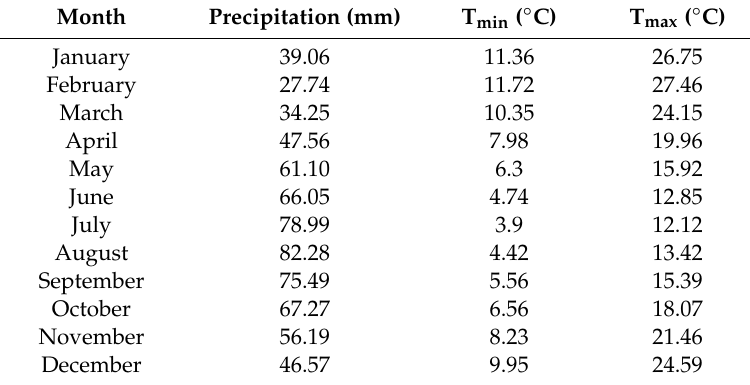
Table 3. Average monthly climate data for the baseline period (1960 to